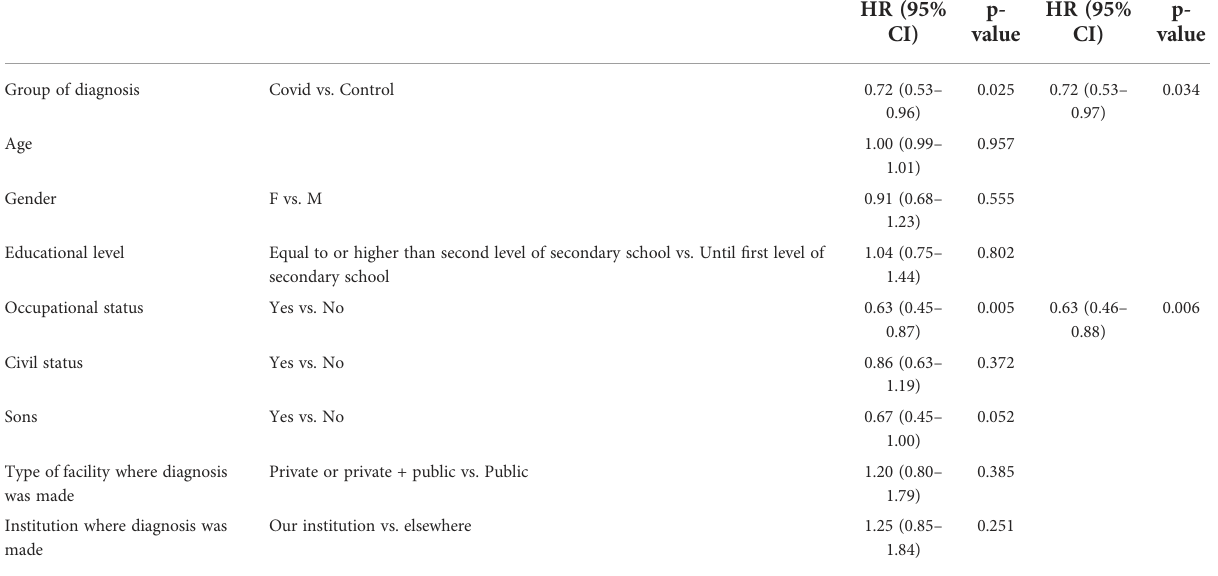
TABLE 2 Univariate and multivariate analysis for the diagnostic delay.